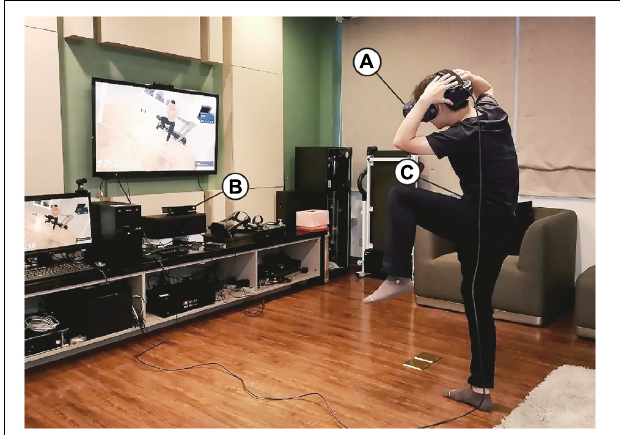
FIGURE 3 | Experimental setup. (A) HTC VIVE head-mounted display (HMD). (B) Microsoft Xbox One Kinect Sensor for actual body movements tracking. (C) ActiGraph GT3X accelerometer for recording physical